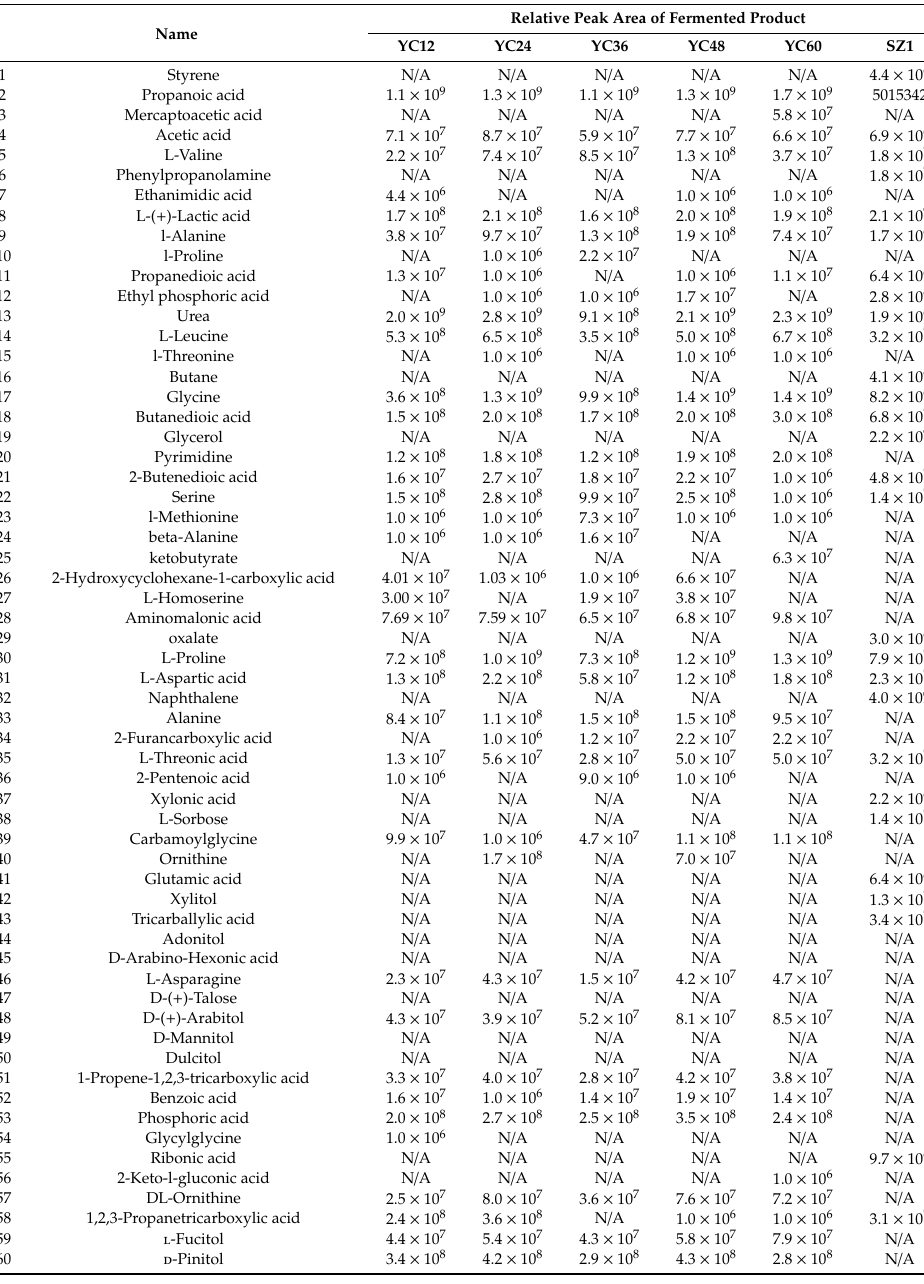
Table 2. Identification of metabolites of yeast